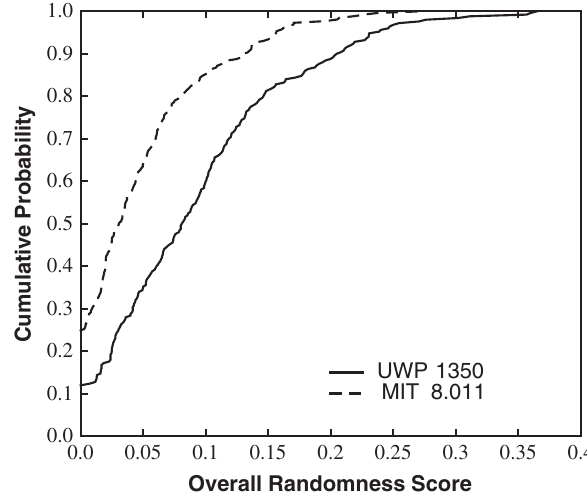
FIG. 3. Cumulative probability distribution of the overall ran- defined in Eq. (6)] by subsample. The total domness score [ R total number of statements used to generate the distributions are 250 for UWP 1350 and 257 for MIT